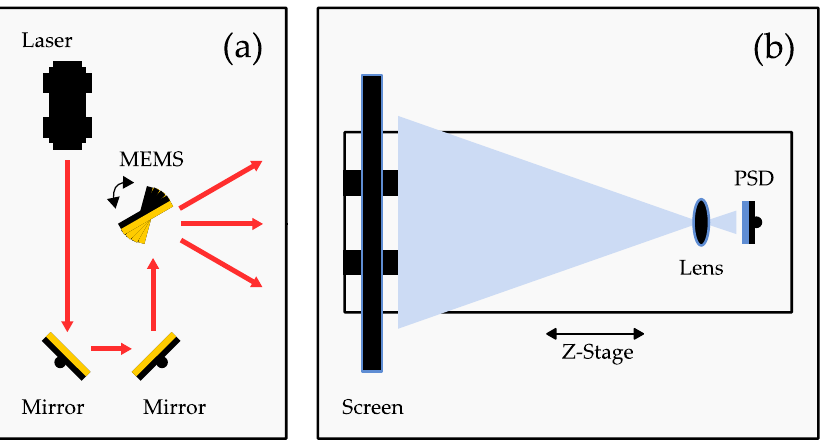
Figure 1. General setup of the testbench: ( a ) emission path; ( b ) detection path.